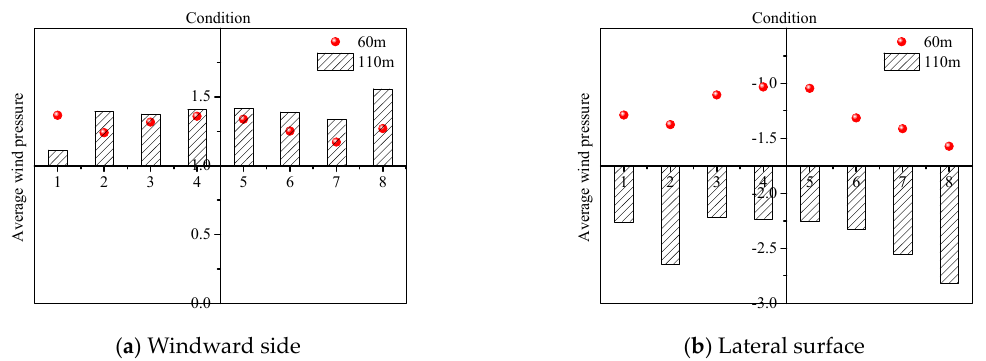
Figure 15. Distribution of average pressure coefficient in the undisturbed zone and disturbed zone under different conditions.